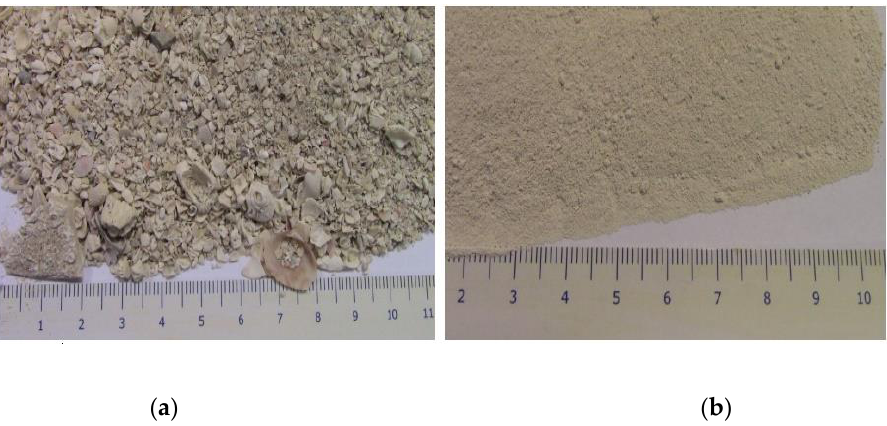
Figure 3. ( a ) Sample of white silicon dioxide before grinding; ( b ) Sample of the white silicon dioxide after pre-griding in PM 400 .